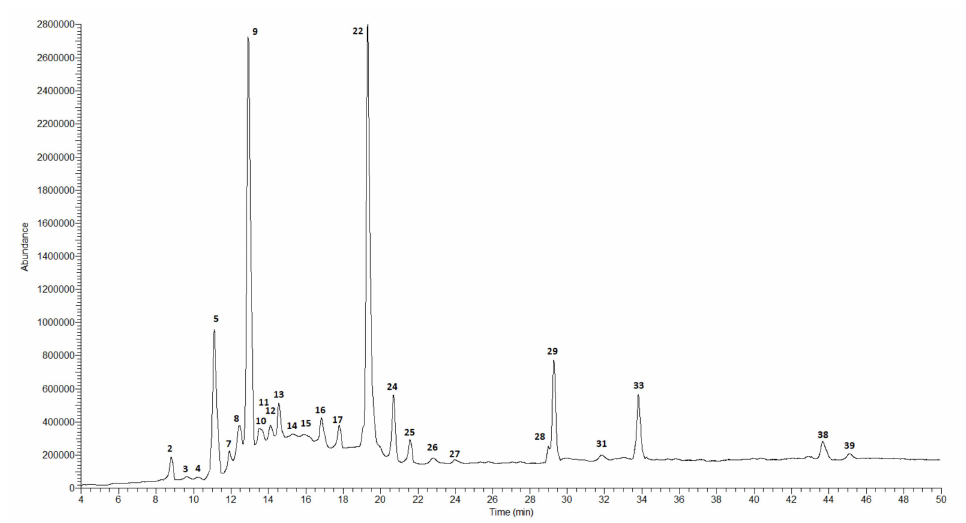
Figure 3. LC-MS chromatogram in SCAN mode for the methanol–acetone–water extract from the fruits of C. roseus .